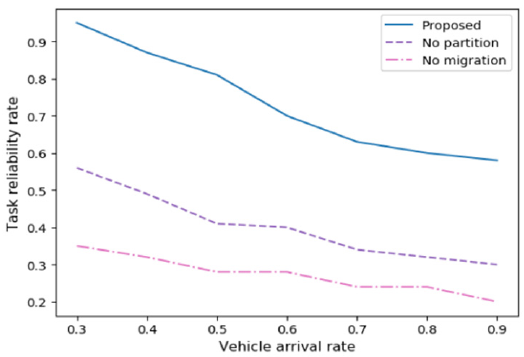
Figure 6. Task reliability rates of the three methods.